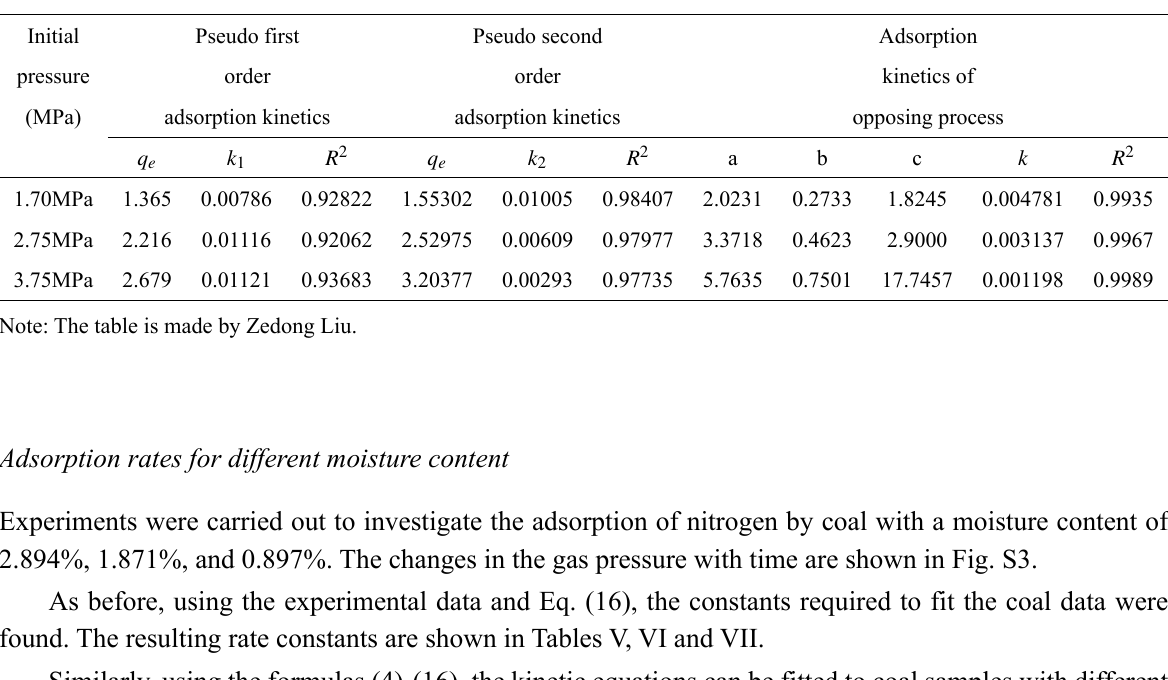
Dry the parameters of the three kinetic equations (Where q t and q e correspond to the amount adsorbed at time t and at equilibrium, respectively, and k 2 is the pseudo-first order adsorption constant where a , b , and c are constants which depend on the initial pressure. R 2 is the correlation coefficient, the closer the coefficient is to 1, indicating that the stronger the correlation, the higher the degree of